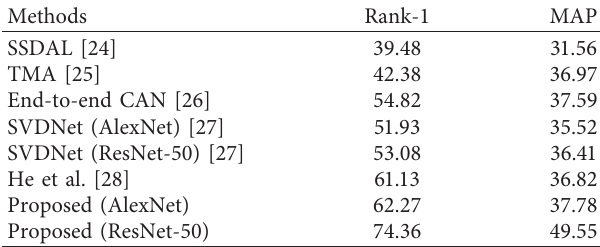
Table 2: The comparison results with self-built datasets. Methods Rank-1